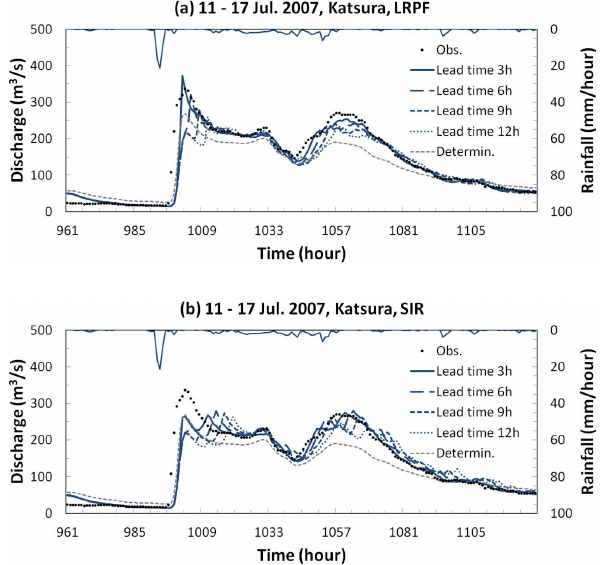
Fig. 11. Observed versus forecasts of varying lead times at the Katsura station via LRPF and SIR with α soil of 0.05 (11 to 17 July 2007): (a) the lagged regularization particle filter (LRPF); and (b) the SIR particle filter. The blue lines represent forecasts of varying lead times. A gray dashed line represents a deterministic modelling case. The black dots represent observed discharge.